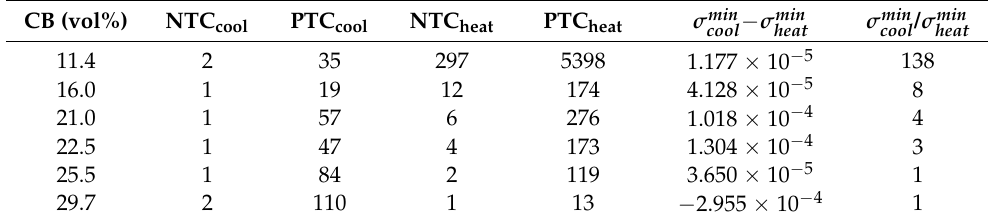
Figure 4. Thermal cycling effect on conductivity for EVA20/CB systems of different loadings. The arrows indicate the cooling and heating curves via the positive and negative temperature coefficients. Table 2. Characteristics of the conductivity as a function of temperature for the EVA20/CB systems.